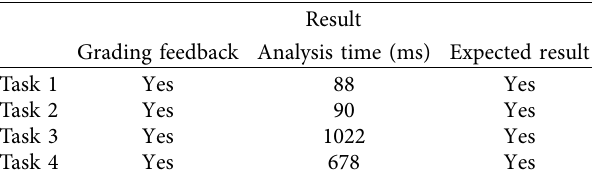
Table 9: General static grading